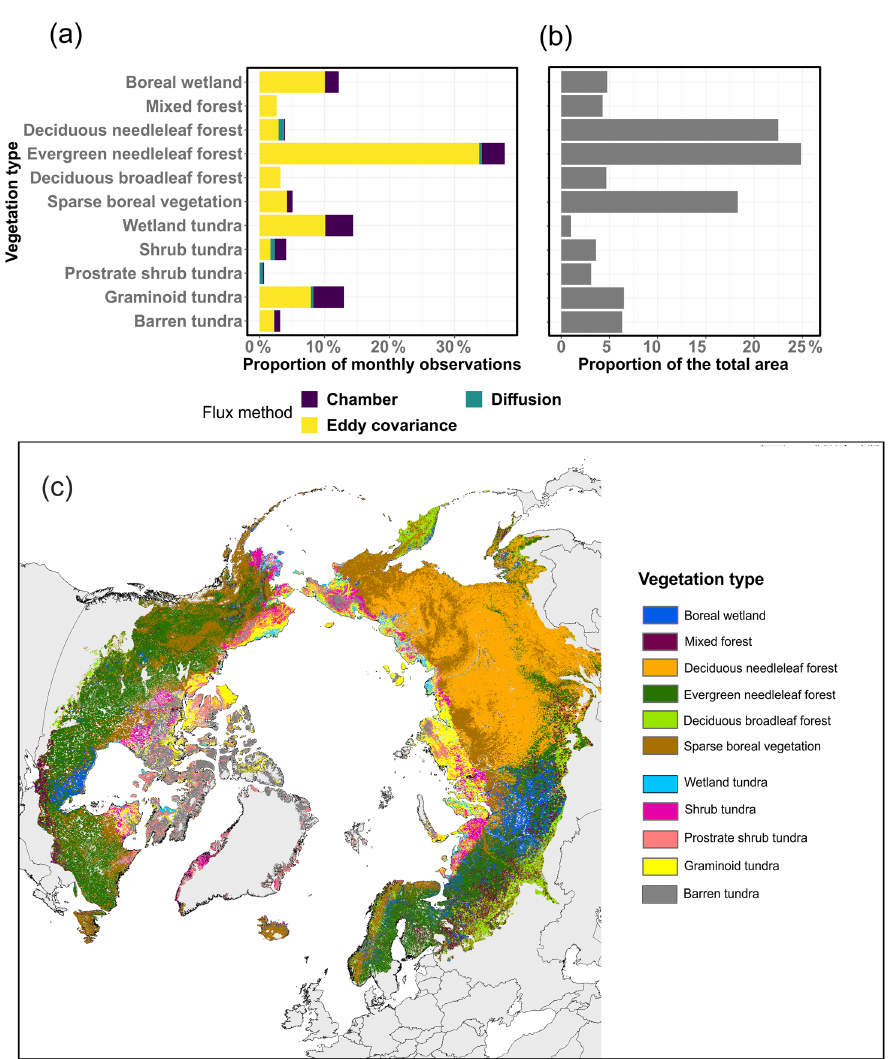
Figure 4. The proportion of monthly observations in each vegetation type colored by the flux measurement technique (a) and the proportion of the areal extent of each vegetation type across the entire Arctic–boreal zone (b) . Permanent water bodies, croplands, and urban areas were masked from the areal extent calculation. Sparse boreal vegetation class in the vegetation map includes vegetation mixtures and mosaics.